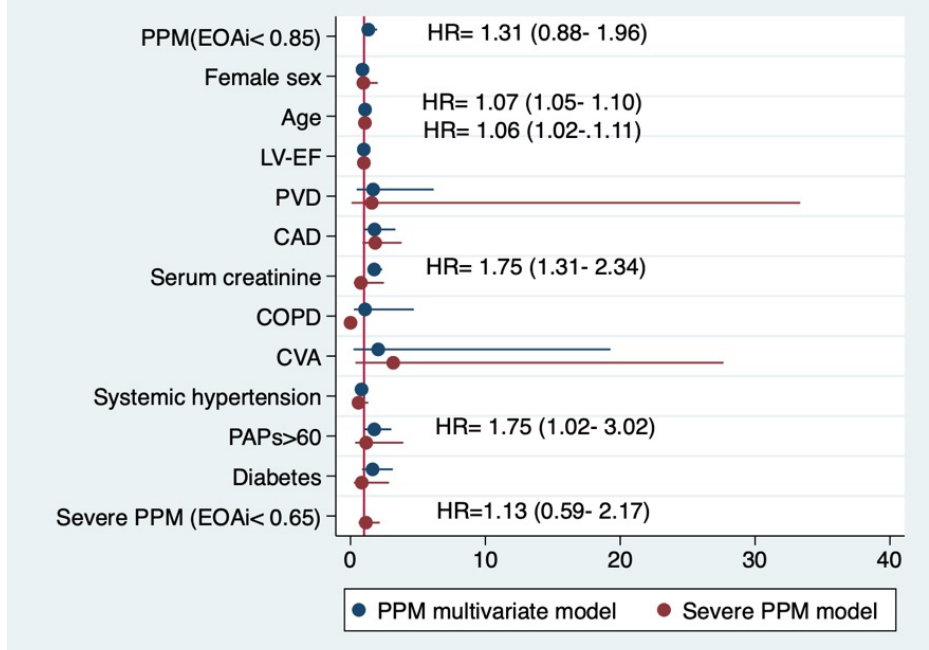
Figure 3. Independent risk factors for impaired long-term survival. The numbers represent the hazard ratio (HR) and the 95% CI. LVEF = left ventricular ejection fraction; PVD = peripheral vascular disease or carotid stenosis >50%; CAD = a stenosis of at least 50% in a major epicardial coronary vessel; COPD = chronic obstructive pulmonary disease diagnosed by spirometry and/or under inhalatory medication; CVA = previous cerebrovascular accident. PAPs = systolic pulmonary artery pressure.